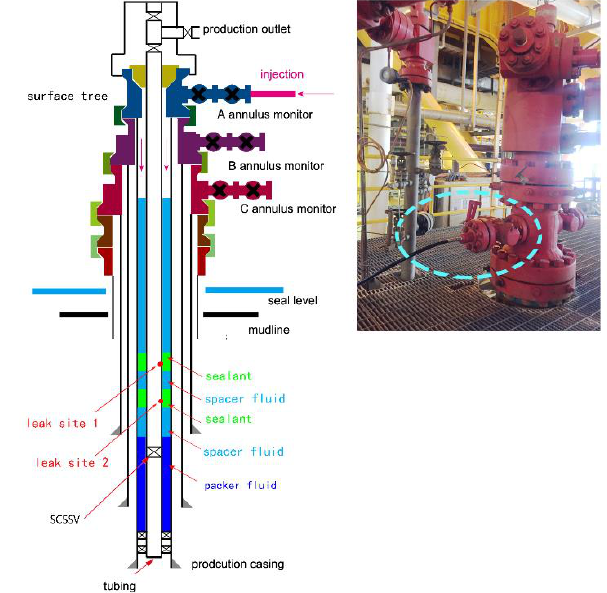
Figure 9. Leak repair implemented using platform delivery. ( Left ): schematic illustration of the slug distribution of the sealant and spacer fluid along the A annuli; ( right ): photograph of the injection contact with the A annulus monitor.